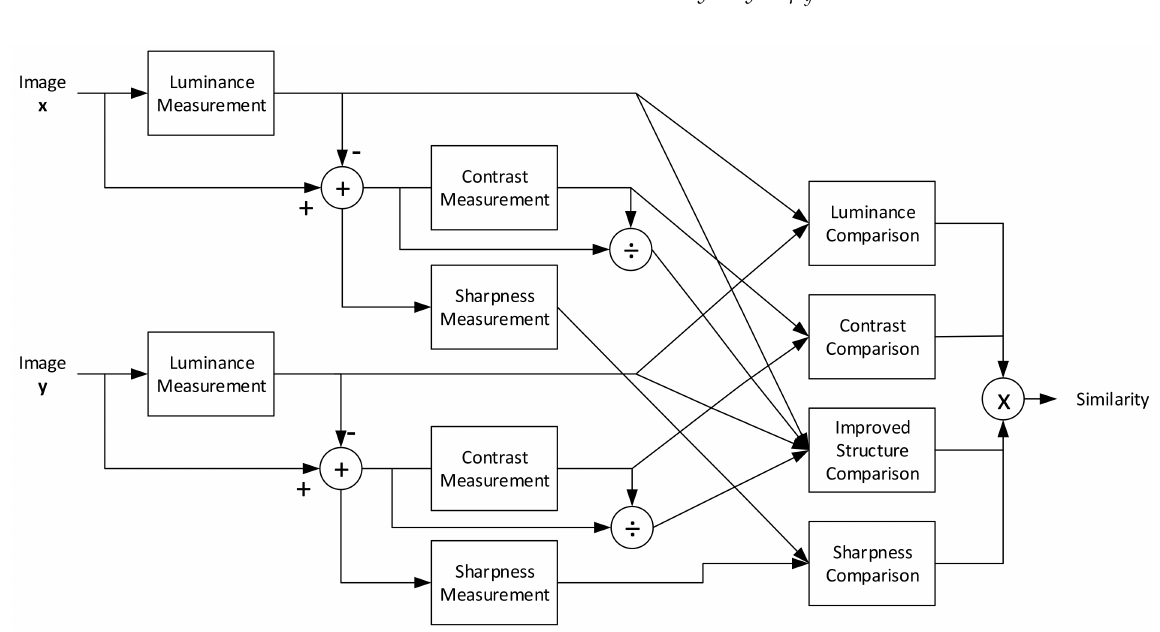
Figure 4. ISSIM-S diagram showing the measurement